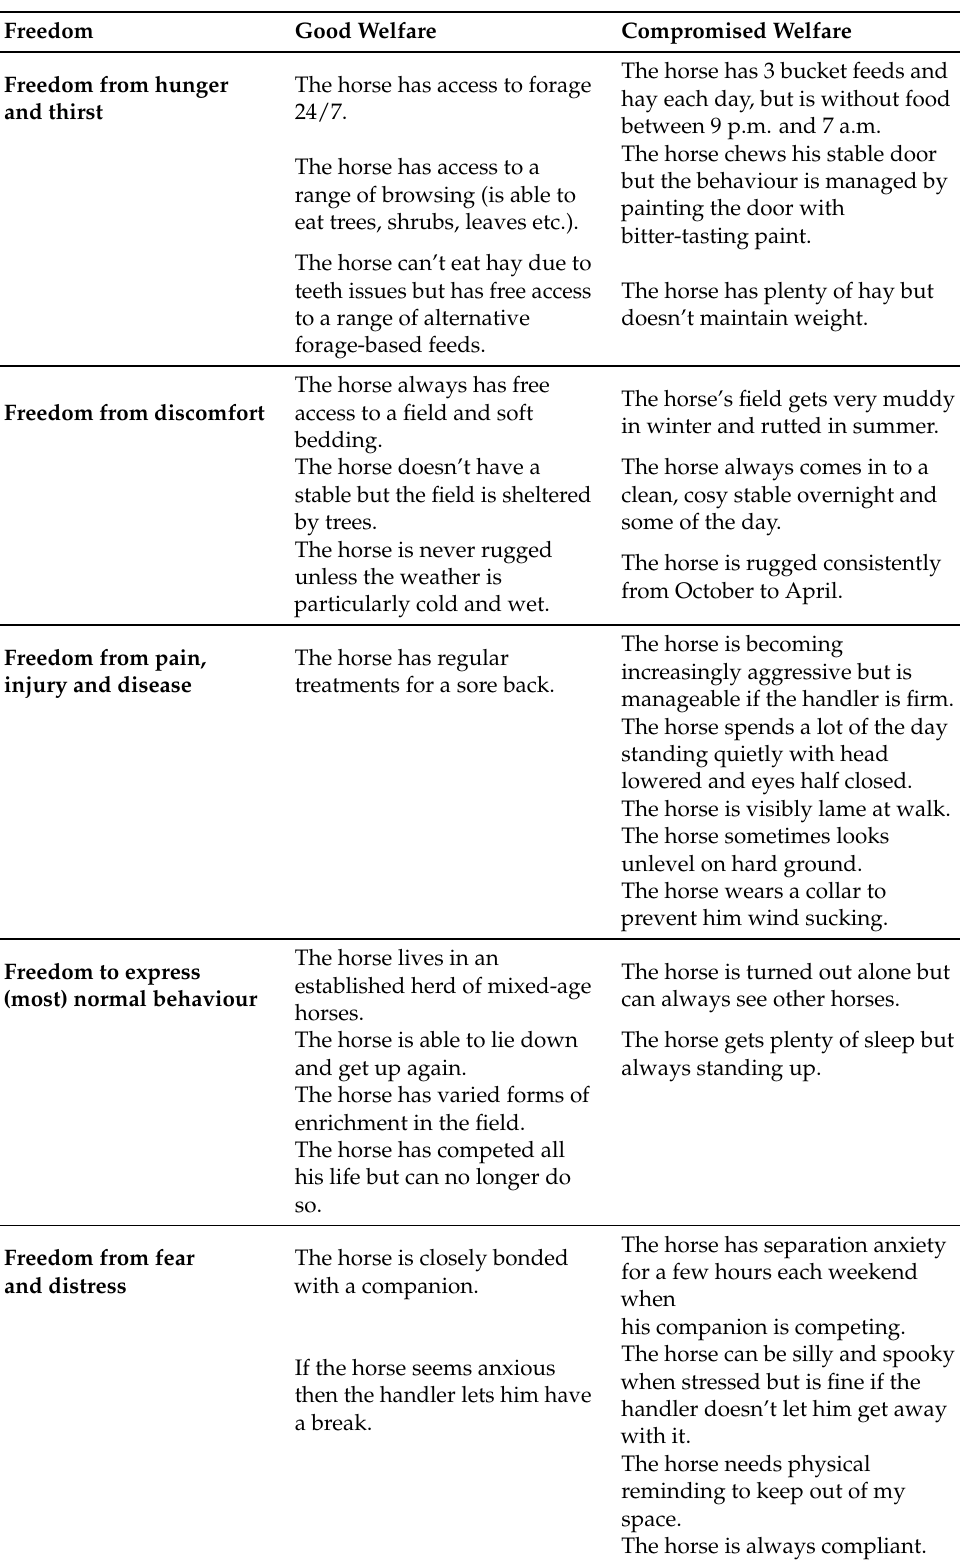
Table 1. Welfare status of each of the 30 scenarios (although some are more debatable than this table suggests, for example attitudes towards rugging). Scenarios are listed according to the Five Freedoms, and presented as pairs of good or compromised welfare where